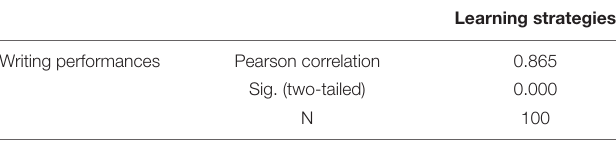
TABLE 6 | Pearson correlation: CTA with writing performances.